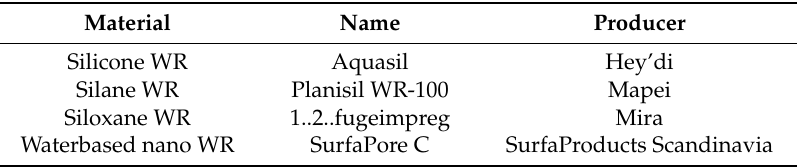
Table 3. Water-repellent impregnation